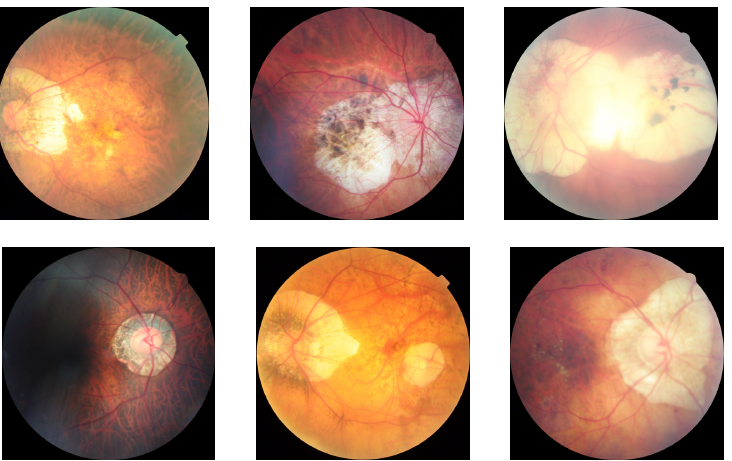
Figure 2. Examples of mined images for PM. Tigroid patterns are noticeable in the field of view of the image and patches of chorioretinal atrohpy are prevalent near the optic